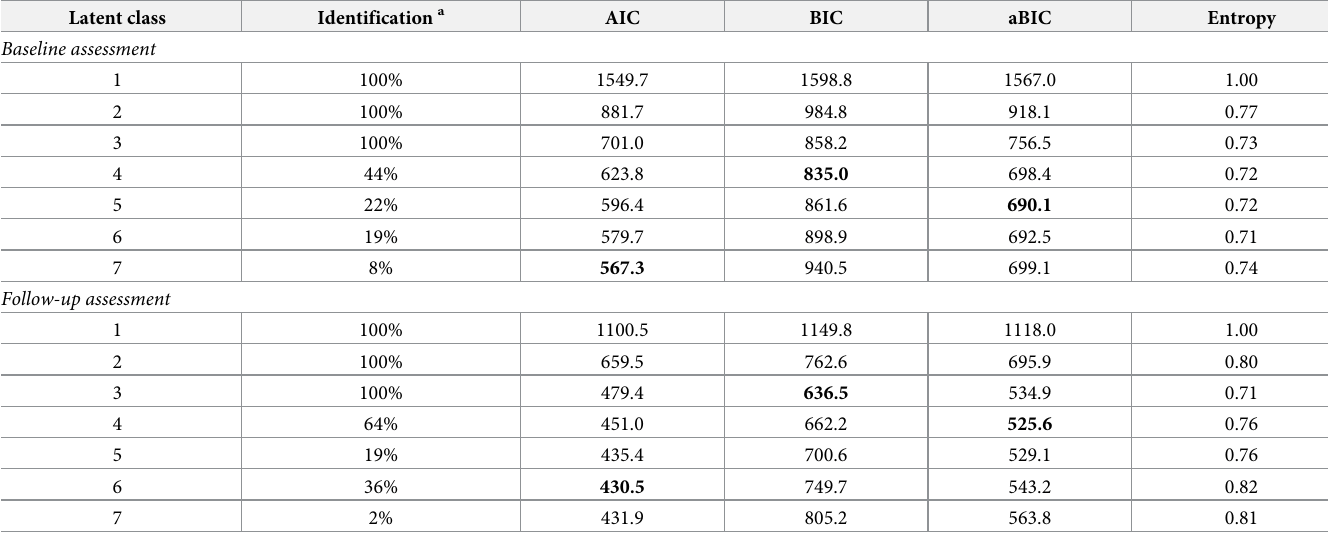
Table 2. Summary of information to select latent class model of college student health and well-being at baseline and at follow-up.